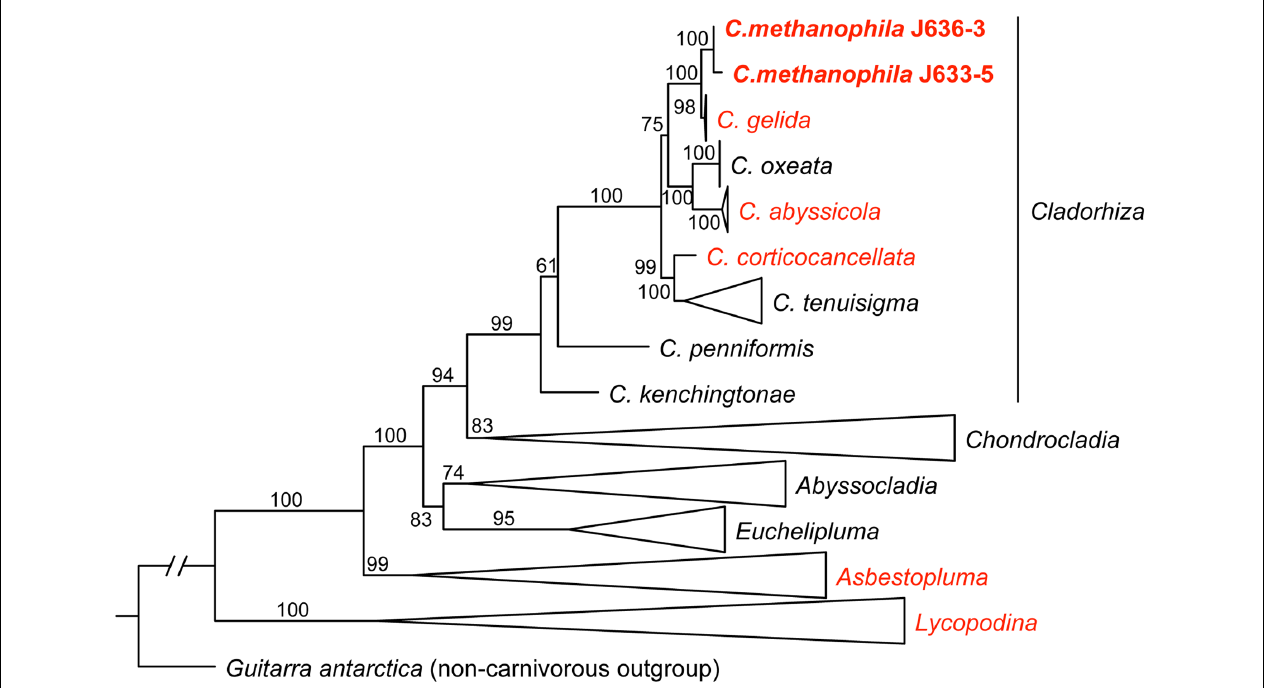
FIGURE 4 | A maximum likelihood (ML) analysis of the carnivorous sponge family Cladorhizidae based on a concatenated dataset of partial 28S rDNA, COI and ALG11 (2859 bp), showing the position of C. methanophila (bold). Taxa in red include species subject to 16S rRNA amplicon sequencing in this study. ML bootstrap value are indicated for each branch. The tree is rooted using the non-carnivorous sponge Guitarra antarctica (Guitarridae). Genera except Cladorhiza are collapsed. Taxa except C. methanophila ( N = 105) were retrieved from GenBank, and were originally published in Vargas et al. (2013); Riesgo et al. (2014) and Hestetun et al.,